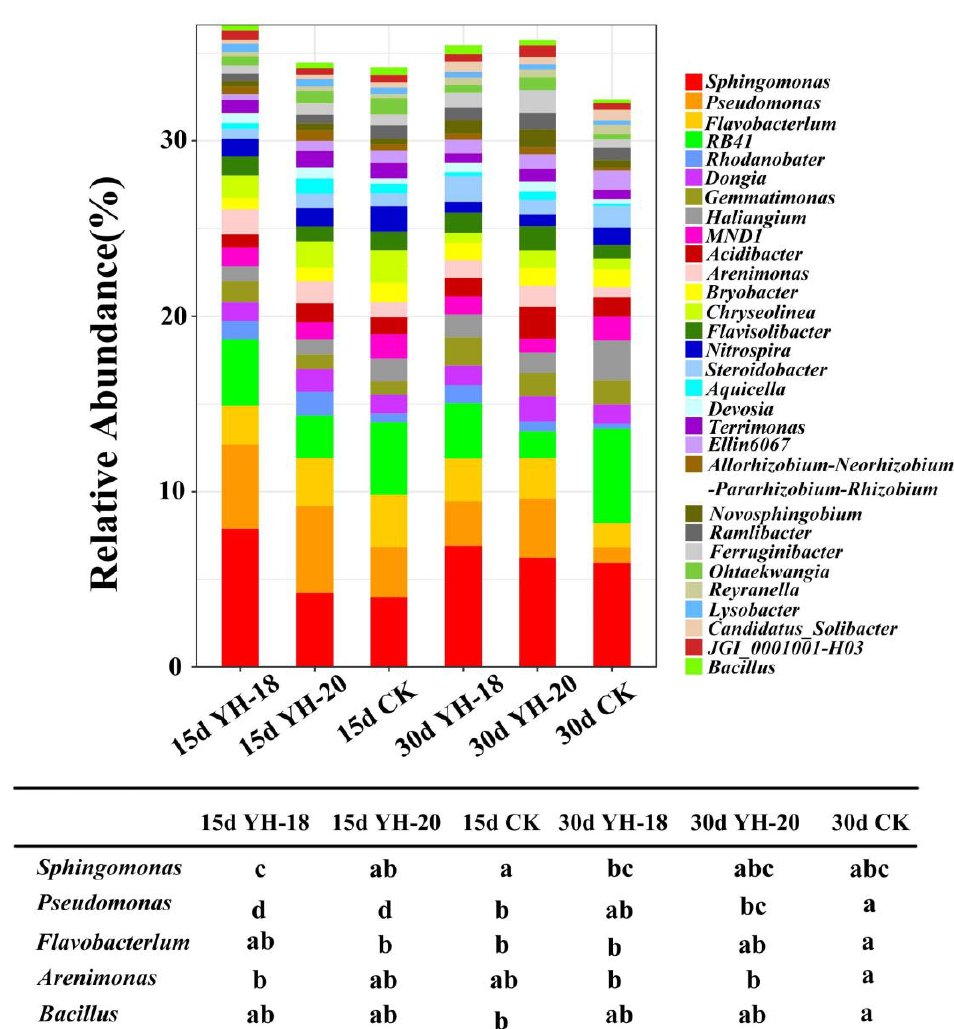
Figure 4. The 30 most abundant bacterial groups at the genus